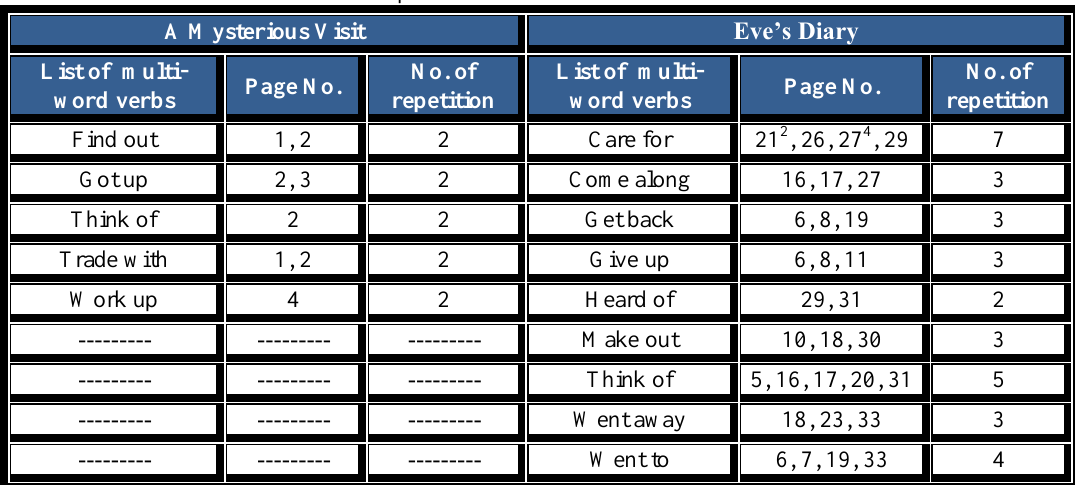
Table 2 – Comparison of MUWVs between MV and ED